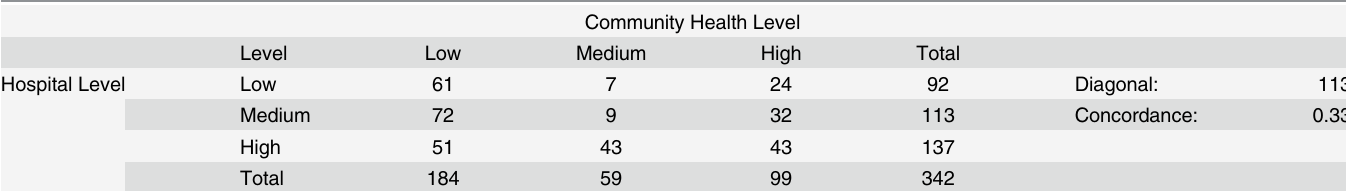
Table 4. ARI Hospital Rates Versus CHW Reported Rates.